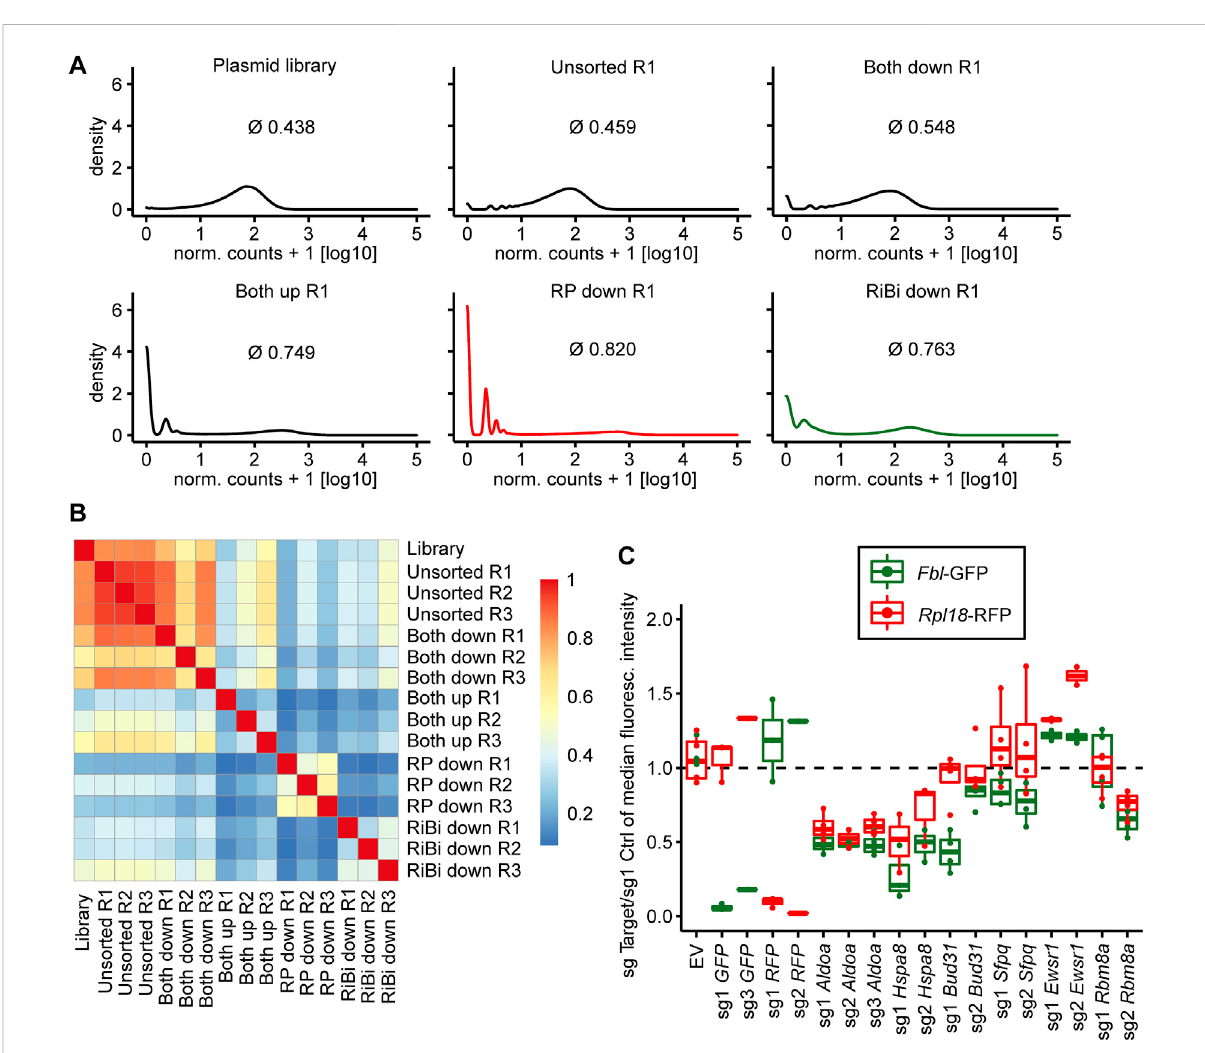
FIGURE 3 Quality assessment of thescreen and validation experiments. (A) Kernel density estimate plots of normalized read count frequencies. Numbers indicate gini coef fi cient (mean over the three replicates). (B) Pearson ’ s correlation of the normalized read counts for each sample of the screen. (C) Boxplot depicting changes in fl uorescence intensity of the screening cell line 3T3 Fbl -GFP; Rpl18 -RFP upon candidate gene knockout. Background- subtracted median fl uorescence intensity of the target sgRNA over a non-targeting control sgRNA is plotted. Boxes indicate 25th and 75th percentile. Horizontal lines within boxes indicate the median. Whiskers extend to 5th and 95th percentile. Dots represent individual